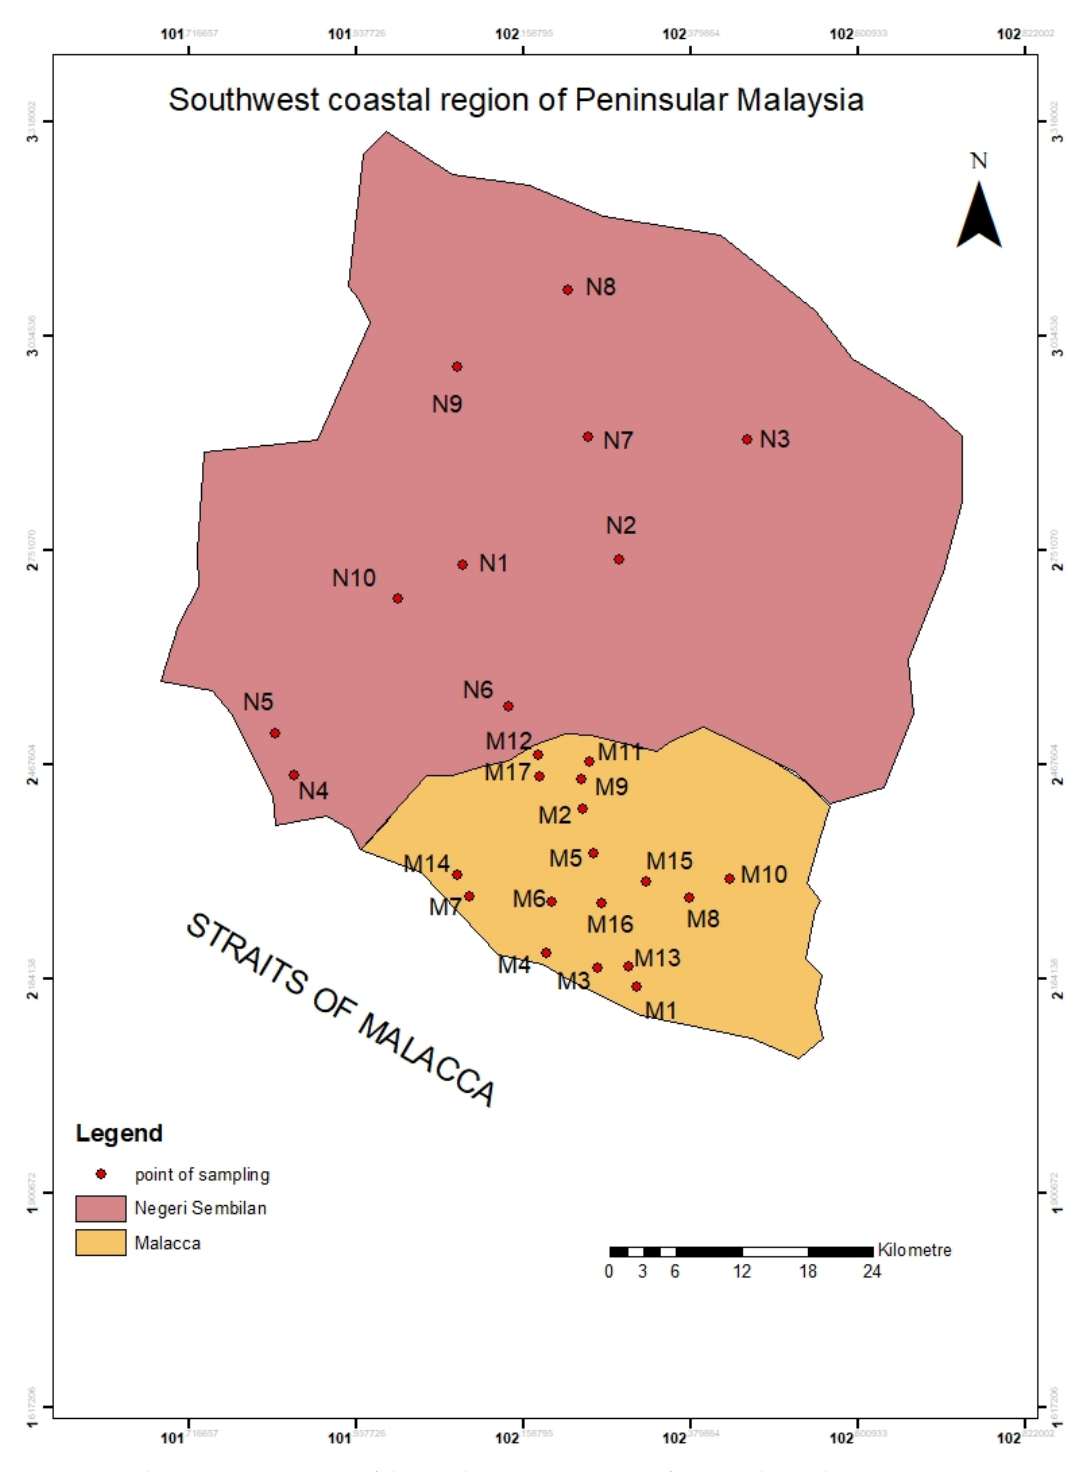
Figure 1. Sampling points in an area of the southwest coast region of Peninsular Malaysia (using ArcGIS 10.4.1).